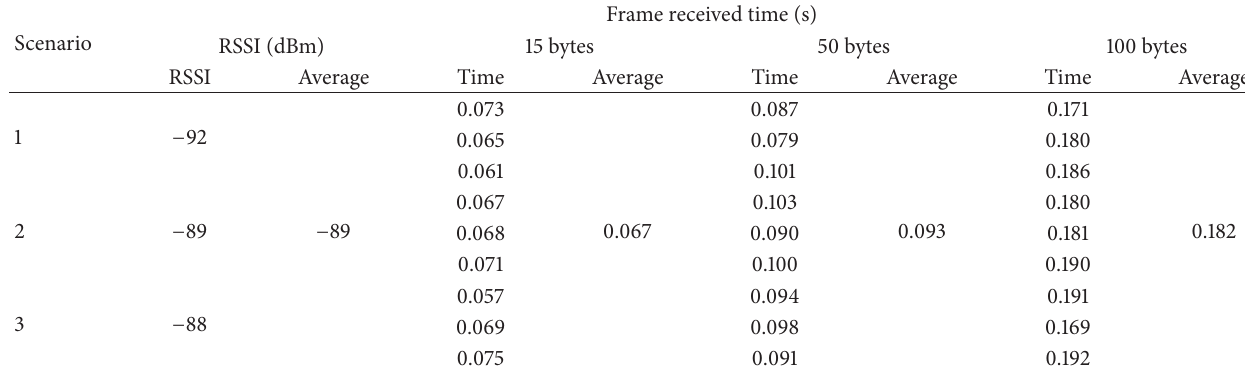
Table 10: Experimental results of Case 5 .